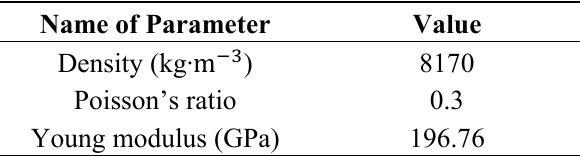
Figure 7. The size of resonator which is simulated. Table 1. The properties of Ni43CrTi.